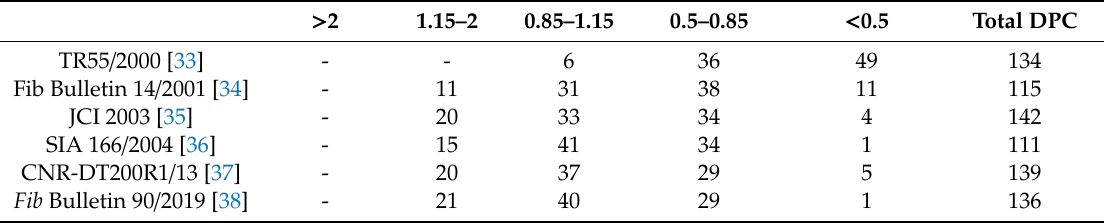
Table 9. Classification of technical guidelines according to Collins’ DPC scale; SRP composites bonded to